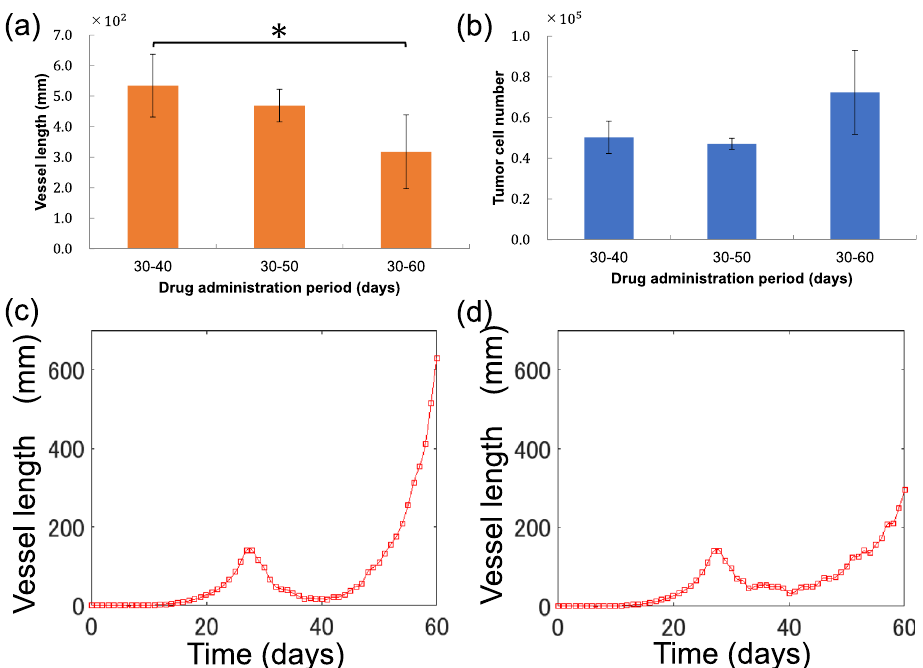
Figure 6. Change in simulation results with intervals of administration ( a , b ) Changes in tumour number and length of new vessels on day 60, according to the treatment period: The x-axis represents treatment conditions, while the y-axes represent the number of tumour cells ( a ) and the length of new vessels ( b ) on day 60. Brs and error bars show the mean and standard deviation, respectively, for each medication condition. * P < 0.05 (Student’s t -test, Bonferroni correction (n = 5)). ( c , d ) Changes in new vessel length during 30–40 days and 30–60 days of drug treatment: The x-axis shows time, the y-axis shows length of new